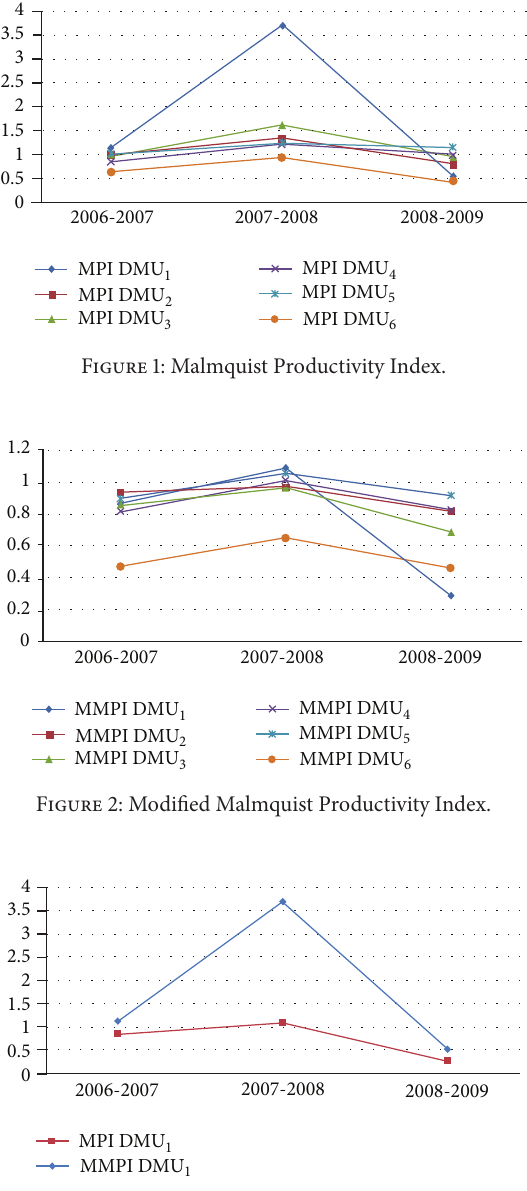
Figure 3: Malmquist changes for DMU 1